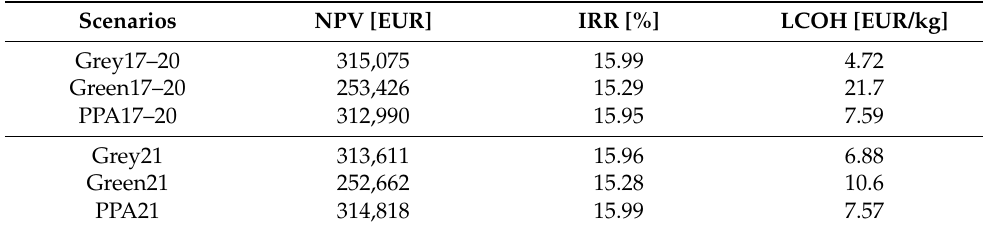
Table 8. Economic metrics (NPV, IRR, and LCOH) corresponding to a 13-year payback.